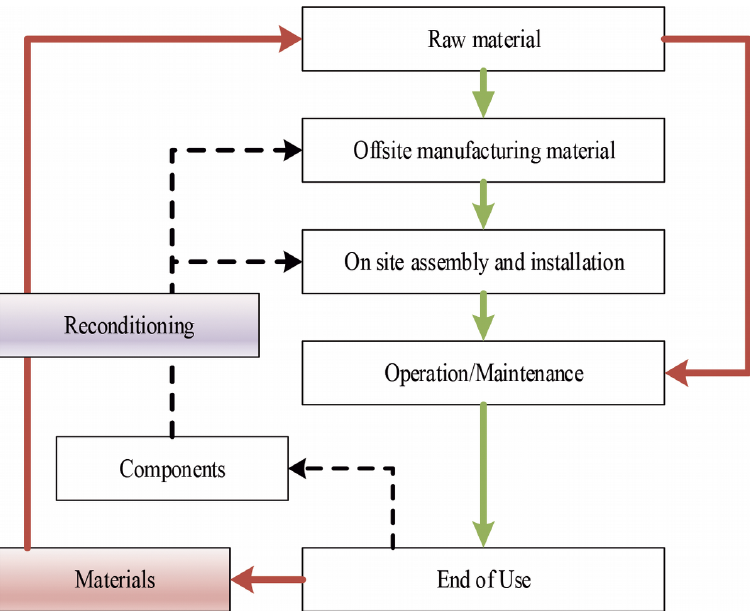
Figure 2. Reverse Logistics Flow Model (Hosseini, Chileshe, Rameezdeen & Lehmann,